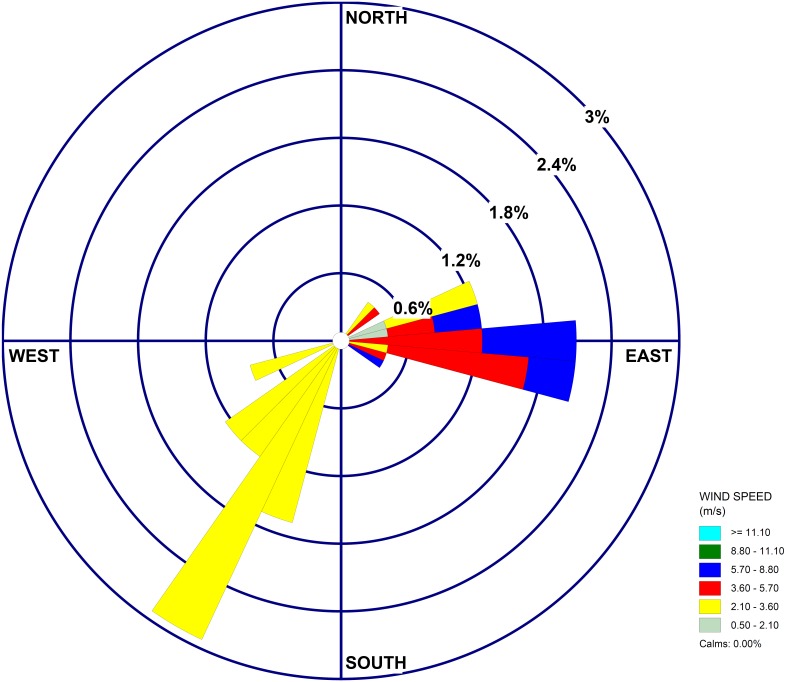
Windrose plot for the period 23 April 2016 to 02 May 2016.Wind speed >=11.10 m/s (Cyan colour), 8.80–11.10 m/s (Green colour), 5.70–8.80 (Blue colour), 3.60–5.70 m/s (Red colour), 2.10–3.60 m/s (Yellow colour), 0.50–2.10 m/s (Light green colour).